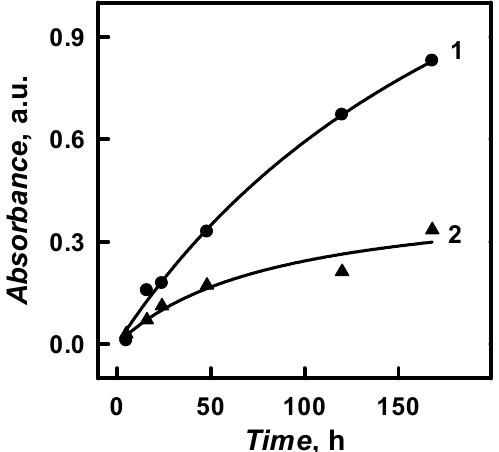
Figure 8. The influence of polymerization duration on PANI / GOx and Ppy / GOx composite nanoparticles optical absorbance. (The composition of polymerization solution: 0.05 mol L − 1 SA bu ff er, pH 6.0, with 0.05 mol L − 1 of glucose, 0.50 mol L − 1 of aniline, or pyrrole and 0.75 mg mL − 1 of glucose oxidase. Optical absorbance was registered in 0.05 mol L − 1 SA bu ff er, pH 6.0, at λ max = 440 nm, and λ max = 460 nm for PANI / GOx and Ppy / GOx, respectively).